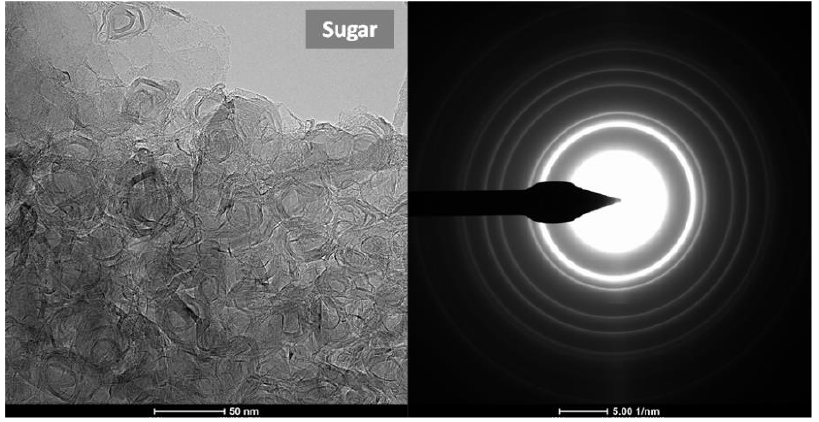
Figure 1. HRTEM image and SAED pattern of the matrix, sugar, after high-temperature heat treatment.